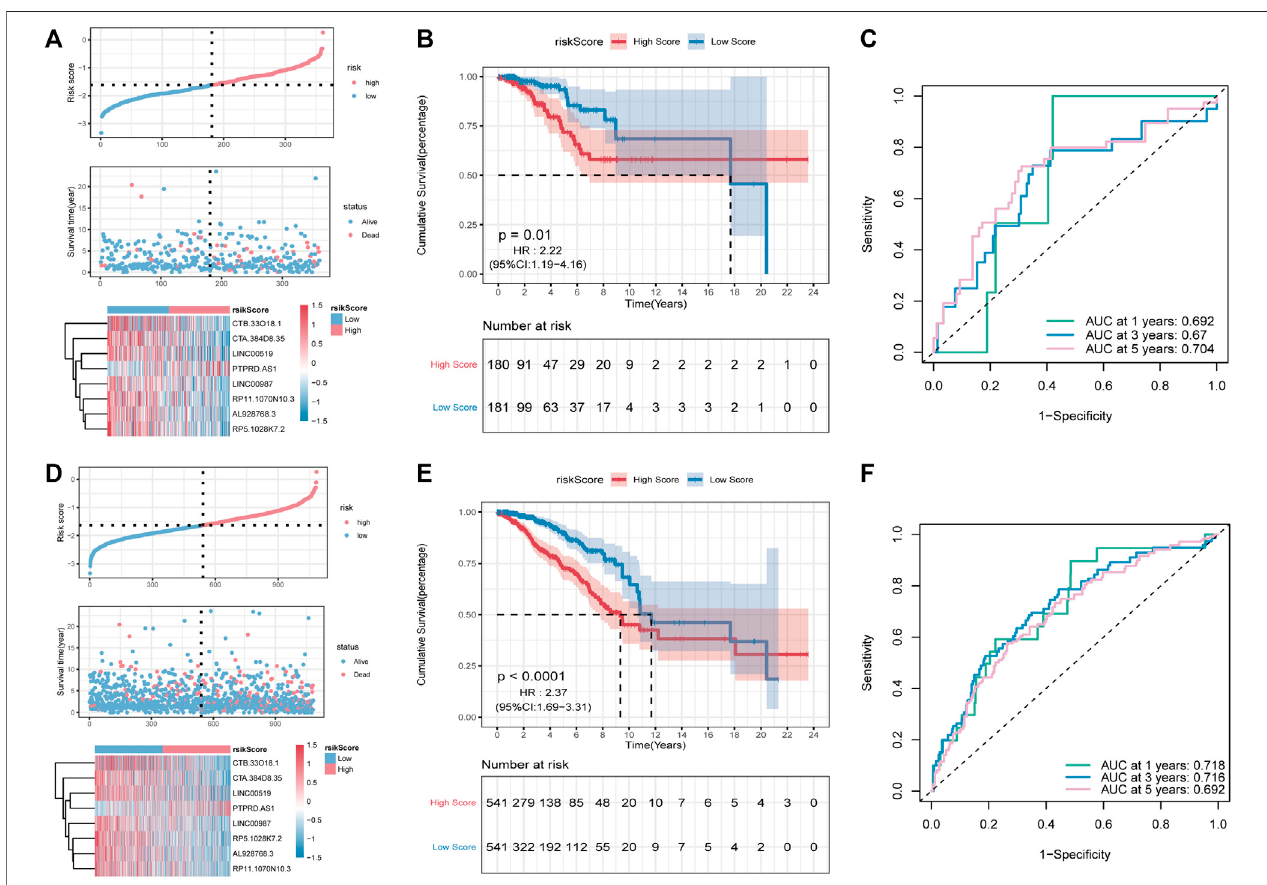
FIGURE 6 | Validation of the PR-Score model in the overall set and validation set. (A – C) The distributions of risk score, survival status, ROC curve in the validation set. (D – F) The distributions of risk score, survival status, ROC curve in overall set.